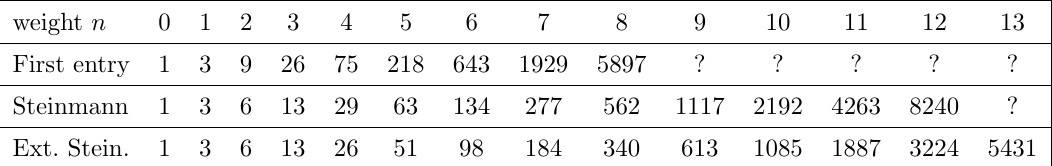
Table 1 . The dimensions of the hexagon, Steinmann hexagon, and extended Steinmann hexagon spaces at symbol